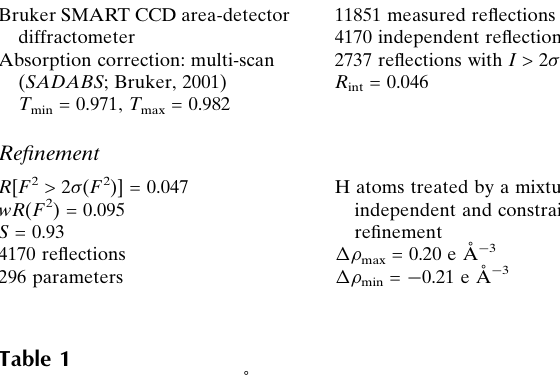
Hydrogen-bond geometry (A˚ , (cid:1)